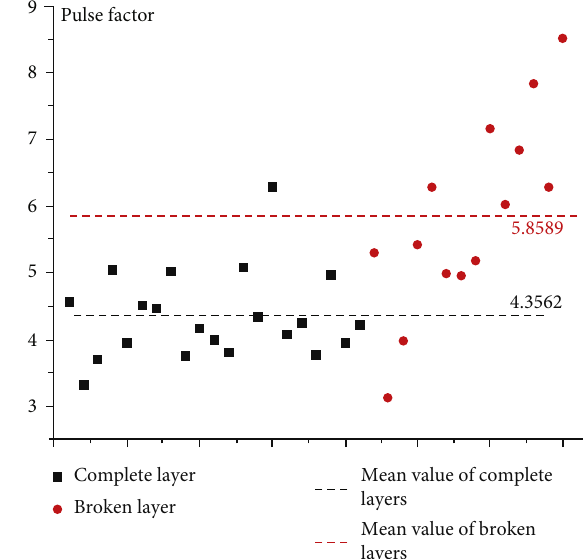
Figure 6: E ff ective value scatter diagram.